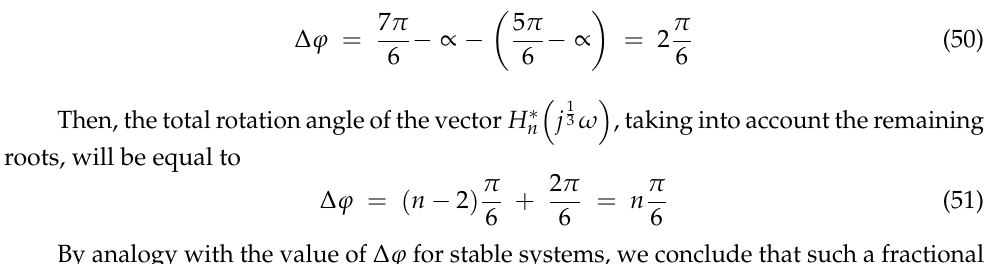
Figure 17. Vector displacement for the first two complex-conjugate roots for the case when 𝜔 𝜖 (0, ∞) .